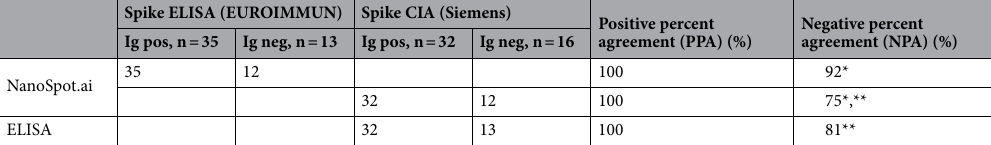
Table 3. Comparative analysis of NanoSpot.ai, Spike-ELISA and Spike-CIA in clinical study. *One discrepant sample from a COVID19-positive patient (NANO_48) scored negative by Spike-ELISA and Spike-CIA, but was positive in the Nucleocapsid CIA (Abbot), NanoSpot.ai and S-Flow assay, suggesting that this sample represents a false negative in the Spike-ELISA and Spike-CIA. **Three Spike-CIA-negative samples (NANO_23, _45, _57) were positive by Spike-ELISA, NanoSpot.ai and S-Flow assay, strongly suggesting false negative interpretation by CIA. One sample (NANO_48) tested negative in the Spike-CIA and Spike-ELISA, but positive by NanoSpot.ai, Nucleocapsid-CIA and S-Flow assay, suggesting false negative interpretation by Spike-CIA and